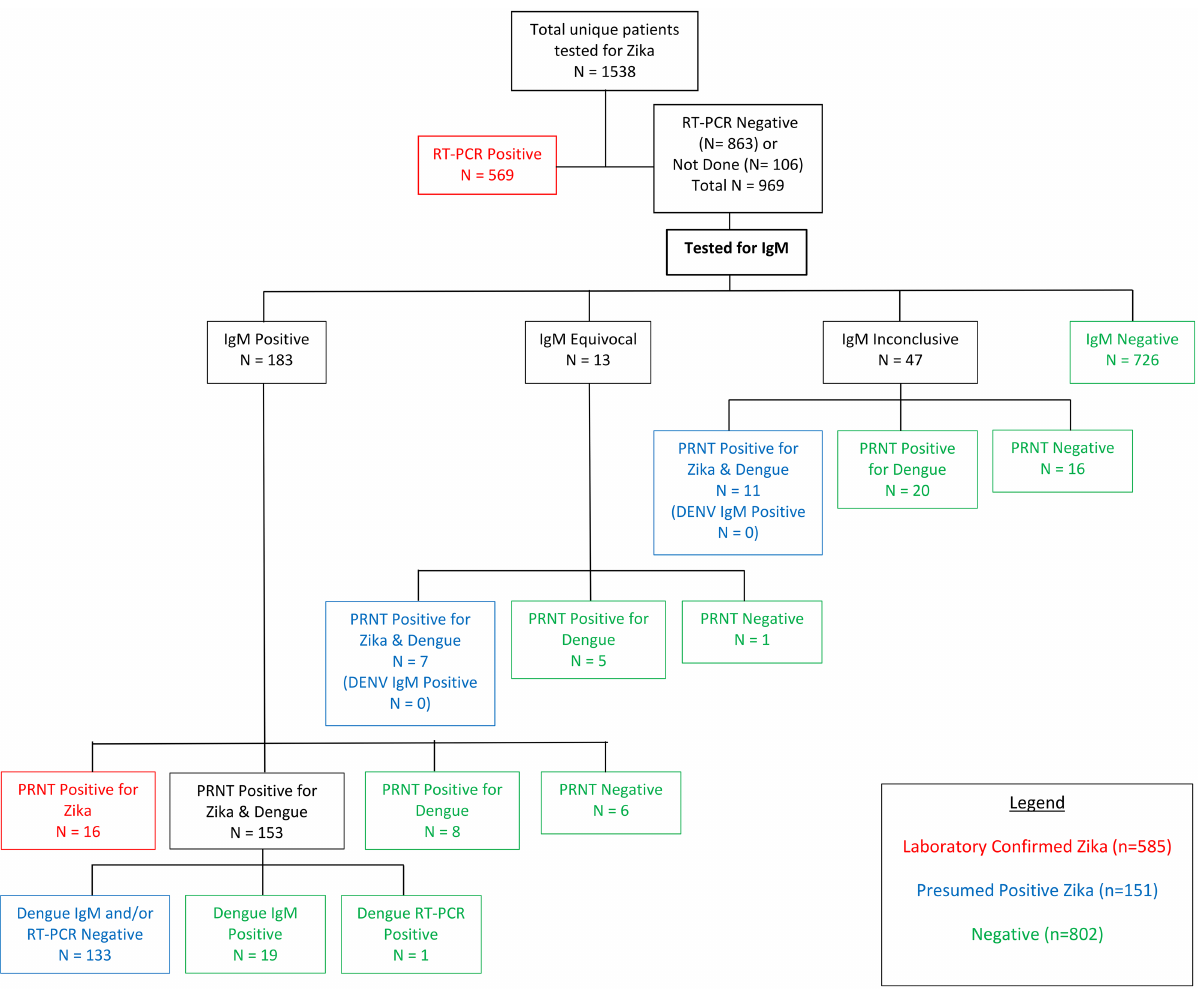
Fig 1. Zika virus flow diagram. RT-PCR, reverse-transcription polymerase chain reaction; IgM, immunoglobulin M; DENV, Dengue virus; PRNT, plaque reduction neutralization testing